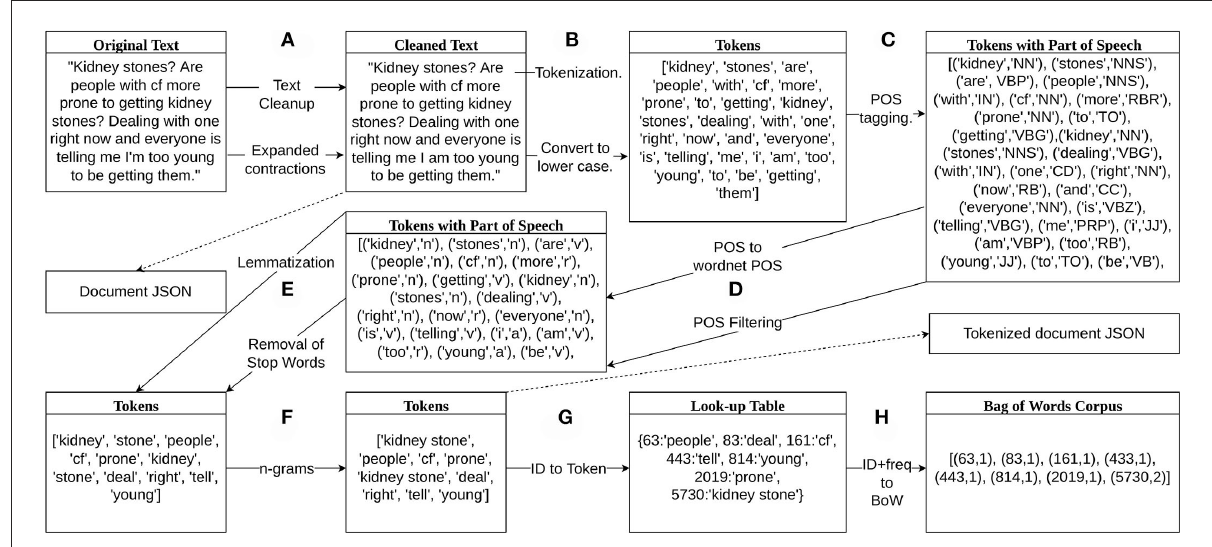
FIGURE1 Data preprocessing diagram. (A) Removed web links, email addresses, and text within brackets and replaced contractions with expanded versions. (B) Tokenized and saved the cleaned text in lower case in a JSON file. (C) Part of speech (POS) tagging. (D) Converted POS to wordnet parts of speech and removed tokens if they are not an adjective, verb, noun, or adverb. (E) Lemmatized tokens and removed stop words. (F) Created bigrams and trigrams from the tokens and saved the list of remaining tokens in a JSON file. (G) Labeled tokens with an integer id and added them to a look-up table. (H) Represented bag of words corpus with pairs of two integers, the first integer is the token id from the look-up table and the second integer is the frequency of that token appearing in the document, e.g., token 5,730, “kidney stone” appears two times in the document and is represented by (5,730,